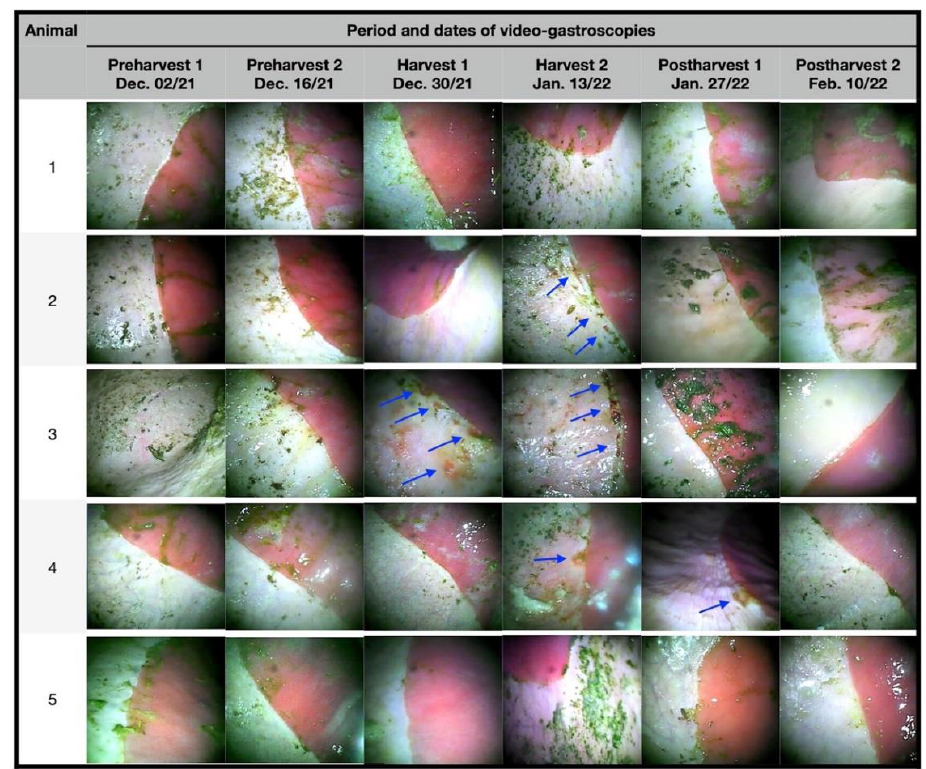
Figure 2. Photographs of the video gastroscopies of experimental animals preharvest (1 and 2), harvest (1 and 2), and postharvest (1 and 2) in the greater curvature region of the squamous and margo plicatus. Numbers at 1st column are the experimental animals’ numbers. Arrows indicate ulcers and erosions areas.